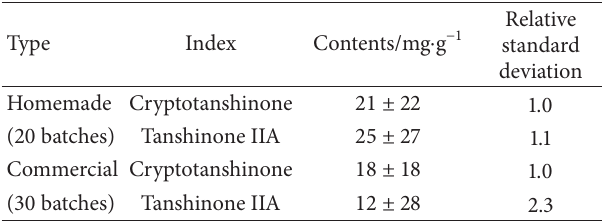
Table 3: The contents of cryptotanshinone and tanshinone IIA of tanshinone extract